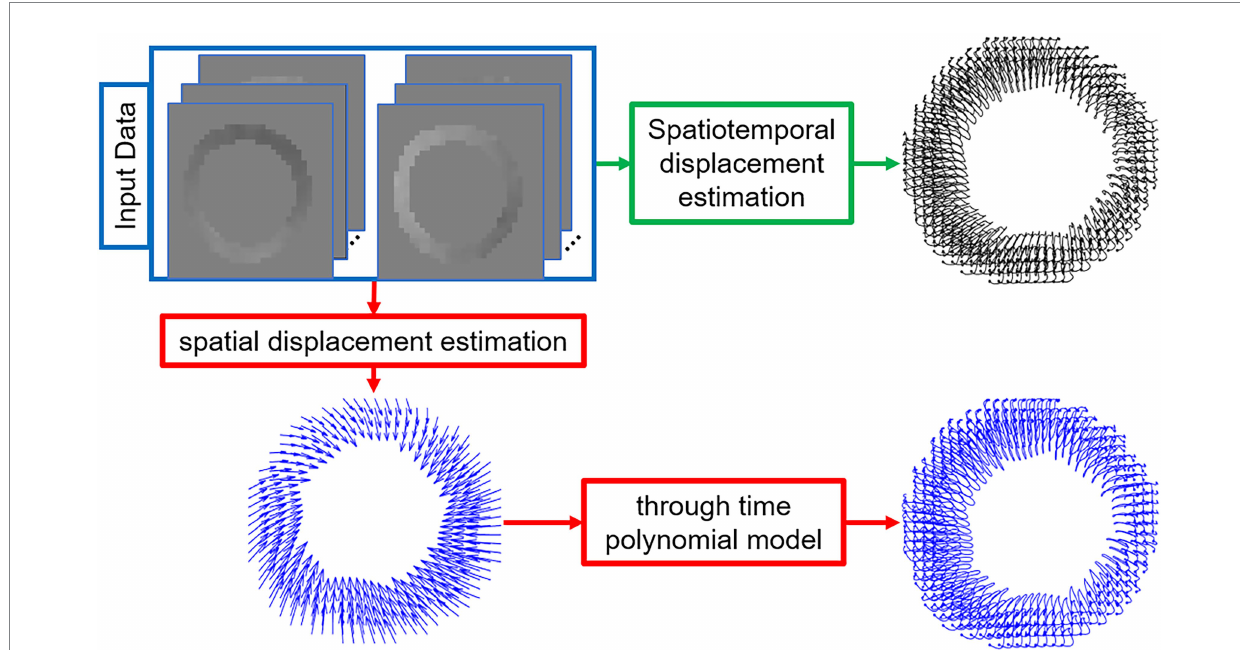
FIGURE 1 Schematic diagrams of the proposed regularized spatiotemporal least squares method (green path) and the commonly used two-step method (red path) to estimate Lagrangian displacement trajectories from DENSE phase images. The input images are the segmented and phase-unwrapped x- and y-encoded cine DENSE phase images and the output is the left-ventricular myocardial Lagrangian displacement trajectories.